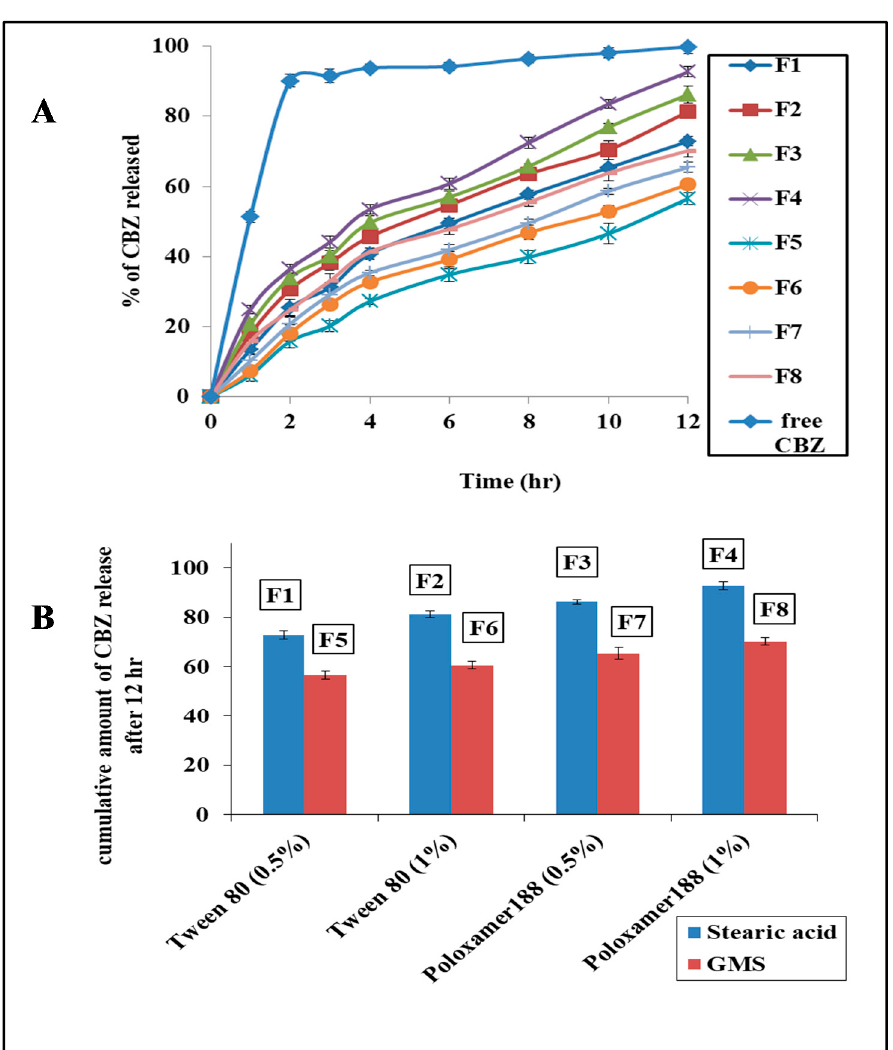
Figure 3. The in vitro release study. ( A ) The release profile of carbamazepine from the prepared carbamazepine solid lipid nanoparticles in comparison to free carbamazepine aqueous dispersion, and ( B ) the effect of lipid type and surfactant concentration on the in vitro release of carbamazepine.